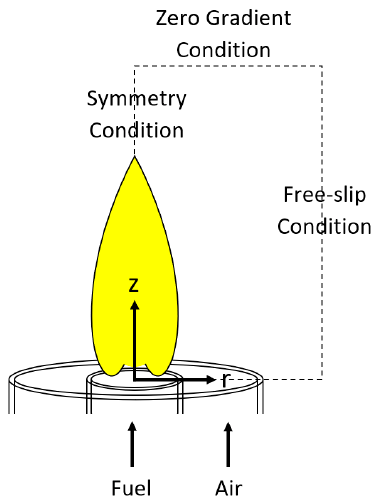
Figure 4. A schematic representation of a laminar diffusion flame along with the coordinates (r, z) and the boundary conditions used in the CoFlame code (adapted from Reference [40]).